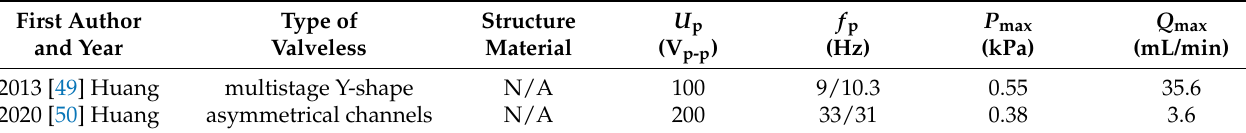
Figure 2. The working processes of valveless piezoelectric pumps with diffuser/nozzle tubes. ( a ) Suction process. ( b ) Discharge process. Table 1. Summary of properties for the valveless piezoelectric pump with external flow tubes.